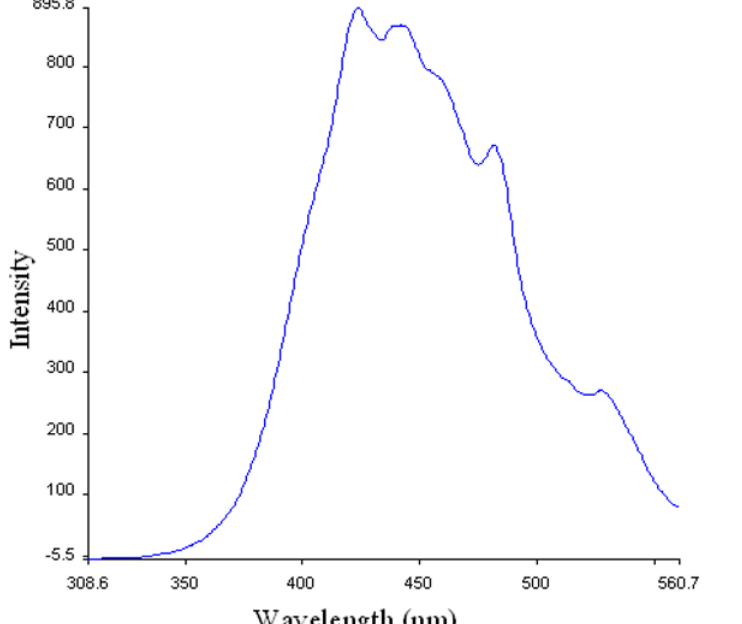
Figure 7. PL spectrum (292 nm excitation wavelength) of MnWO